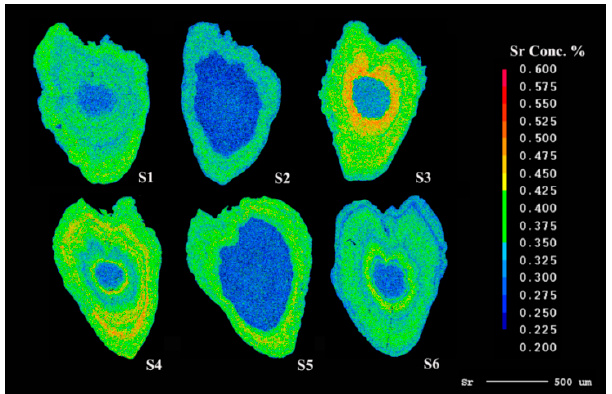
Figure 6. Two-dimensional imaging using X-ray electron microprobe analysis of the Sr concentrations in the sagittal plane of the otoliths of individual Coilia nasus from Shengsi Sea area, China. The values corresponding to Sr concentrations are represented by 16 colors from red (highest) through yellow and green, to blue (lowest).